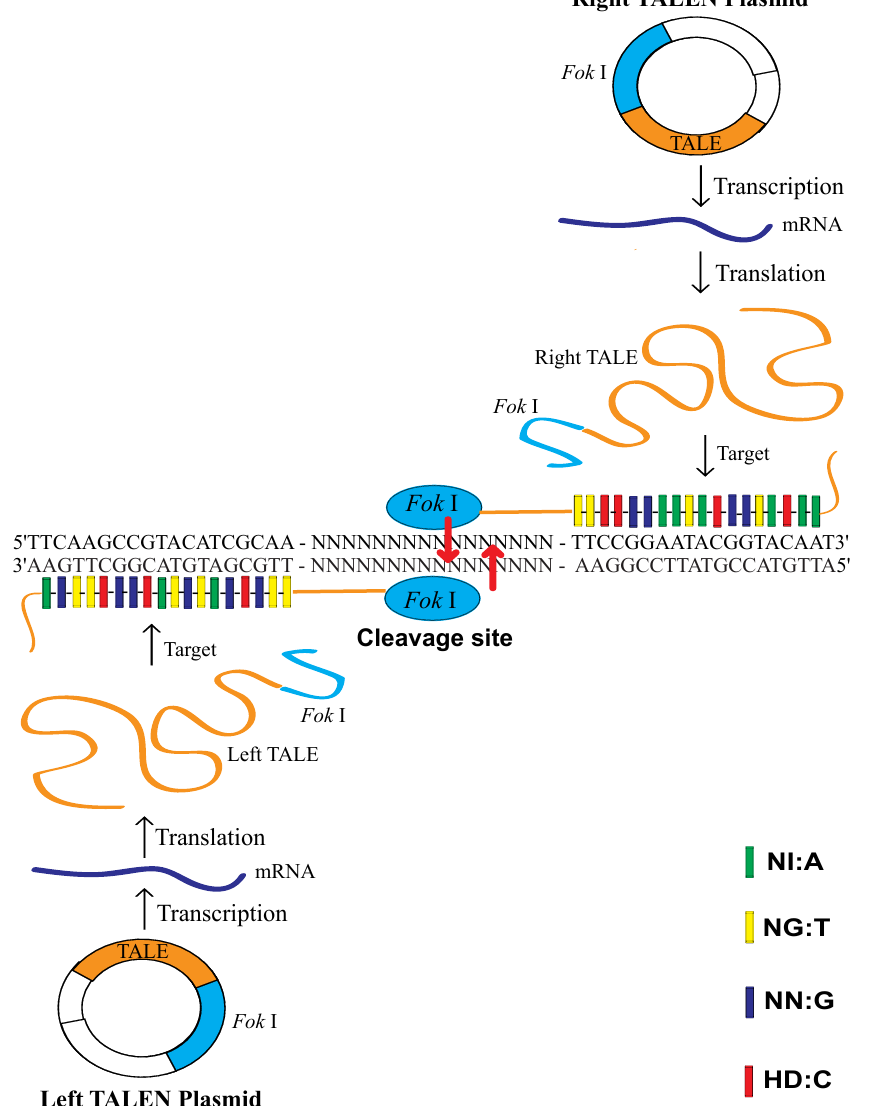
Figure 1. Transcription activator-like e ff ector nuclease (TALEN) targeting and cleavage on the target site. The specific repeat variable di-residue (RVD) used to recognize each base is indicated by shading, as defined in the key (NI: A, NG: T, NN: G, HD: C). The cleavage site is in the adjoining region between the left and right target site. The left transcription activator-like e ff ector (TALE) and the right TALE of TALEN plasmids recognized their target sequence and allowed their associated Fok I endonucleases to work as homodimers to cleave the sense strand 9 bp and antisense strand 13 bp downstream of the binding site. The binding of the TALEs to the target sites allows Fok I to dimerize and create a double-stranded break (DSB) with sticky ends within the